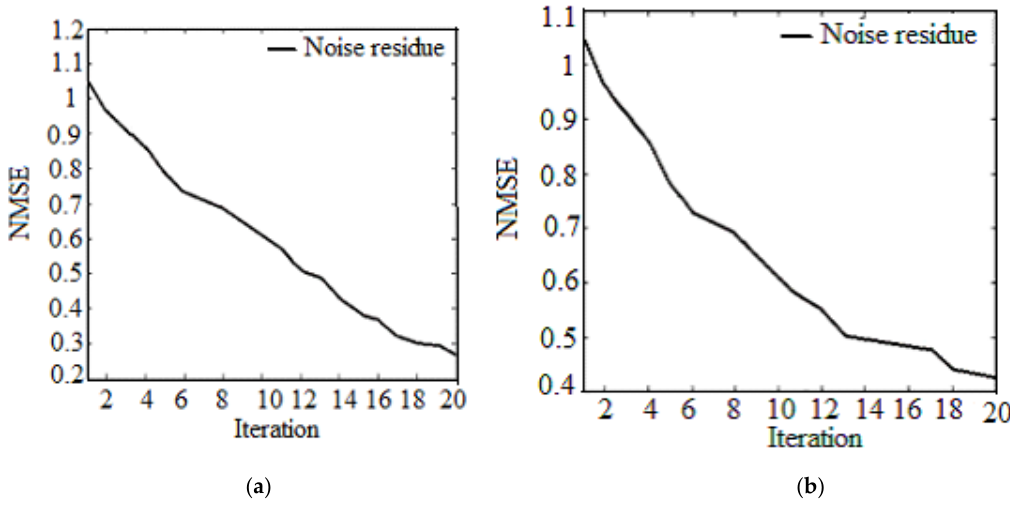
Figure 8. Number of iterations versus normalized mean square error ( a ) Proposed method; ( b ) Existing method (FsLMS).